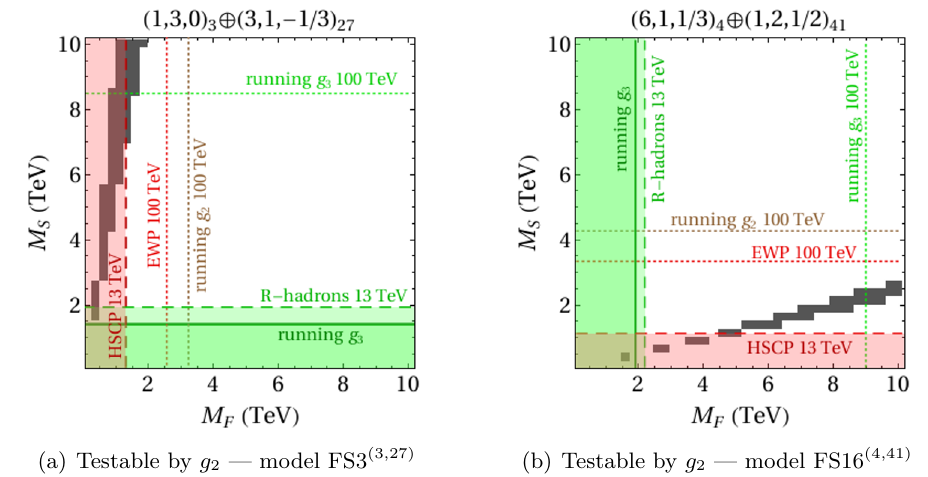
Figure 3 . Summary of experimental bounds on masses M 1 and M 2 for scenarios (a) FS3 (3 , 27) and (b) FS16 (4 , 41) . The color code is the same as in figure